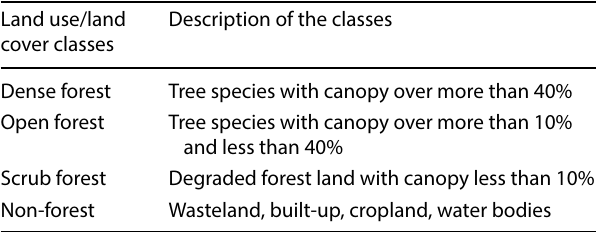
Table 11 Description of land use/land cover class Land use/land cover classes